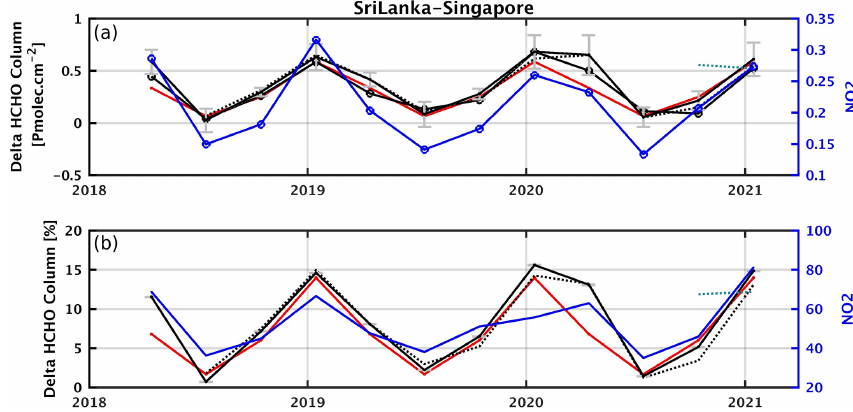
Figure 21. Seasonal variation in the absolute (a) and relative (b) column deviations of the TROPOMI HCHO (black), OMI 2005–2009 cli- matology HCHO (red) and TROPOMI NO 2 (blue) tropospheric columns along the Sri Lanka–Singapore line. For each season, the maximum deviation compared to the background is provided. The results of the analysis are given for the slant and the vertical columns (circles/lines), using a stricter cloud filtering (CRF < 20%, black dotted line) and an additional filter on the wind velocity ( W < 5ms − 1 , green dotted line). (Pmolec.cm − 2 = 1 × 10 15 molec.cm − 2 .)